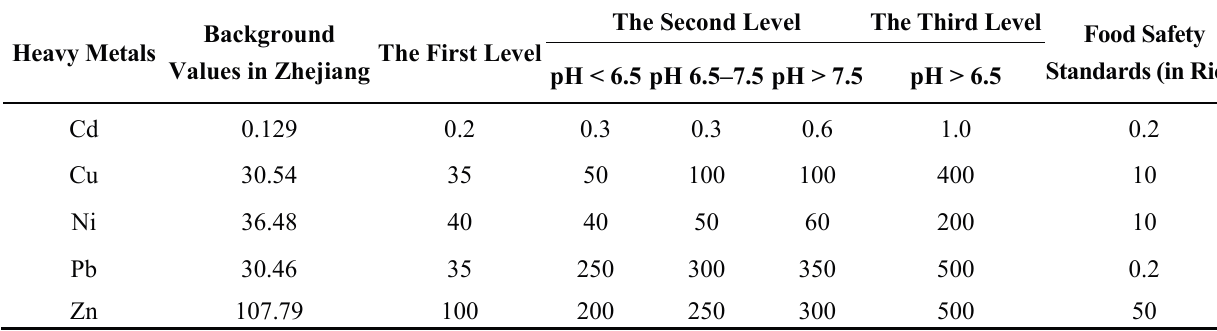
Table 1. The background values of heavy metals in soils in Zhejiang and environmental quality standard for soils in China, heavy metal standards for food safety (mg·kg − 1